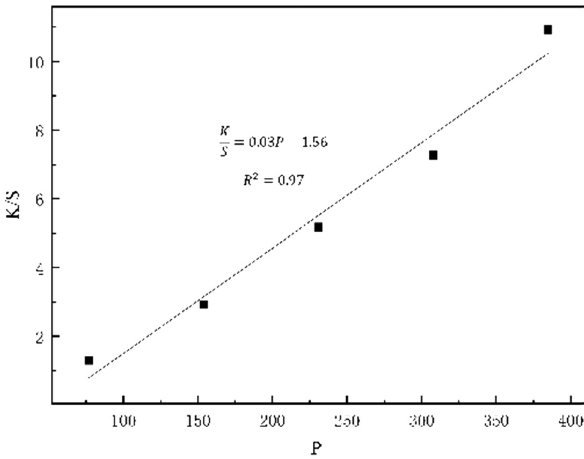
Figure 2: Relationship between the color depth K/S of the spun - dyed fi ber and the performance P of pigment in the fi ber.